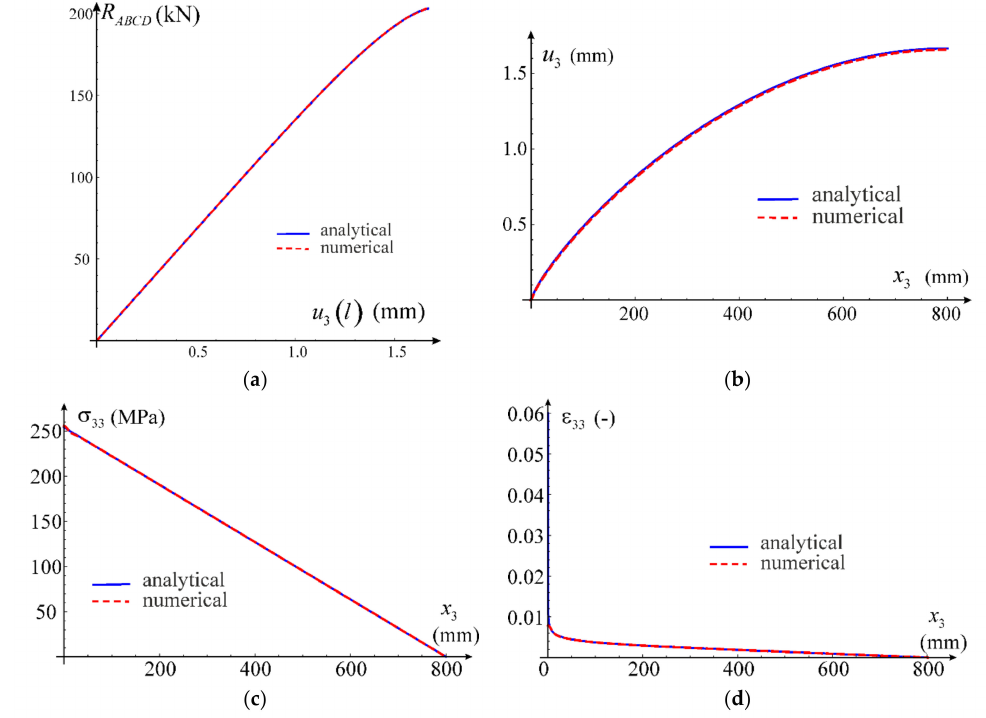
Figure 13. Comparison of analytical and numerical solutions for the rod: ( a ) reaction versus maximum displacement, ( b ) displacement, ( c ) stress, ( d )